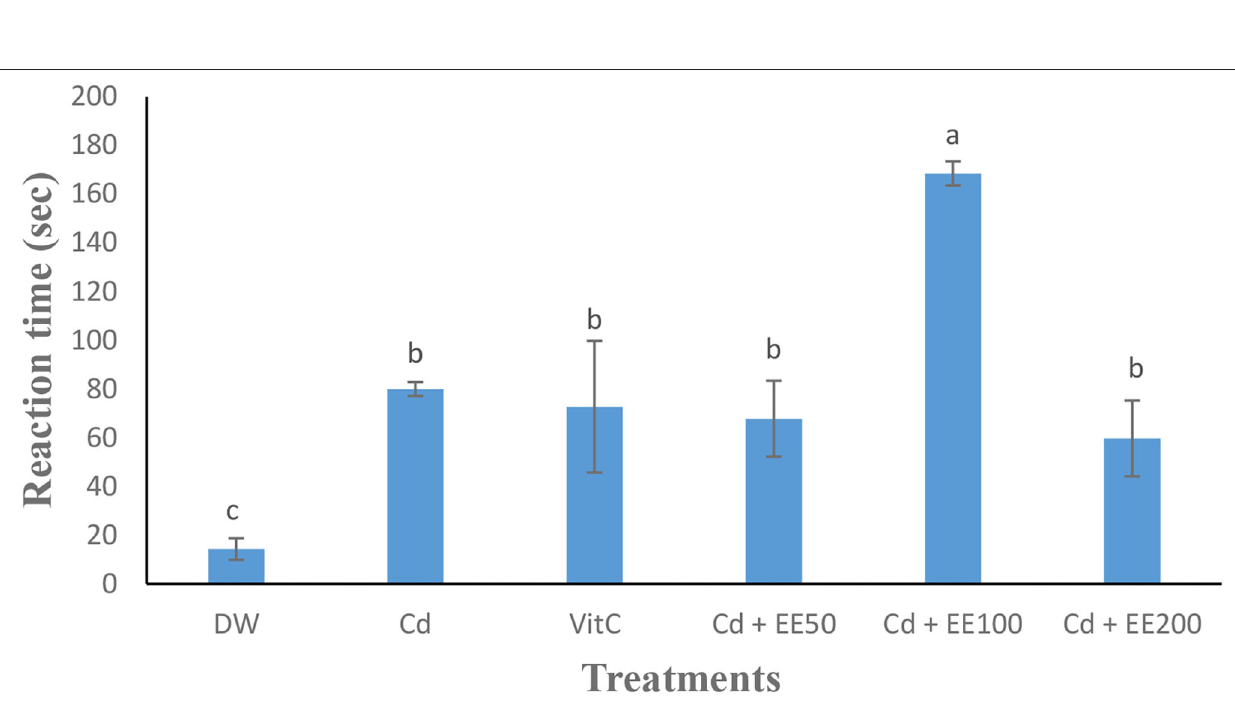
of Akunna et al. (31) in which the co-administration of chromium (150 mg/kg bw) with Moringa olifera (60 mg/kg bw) for 100 days led to the improvement of spermatozoa characteristics. The increase in sperm count, motility, and plasma membrane integrity and decrease of the